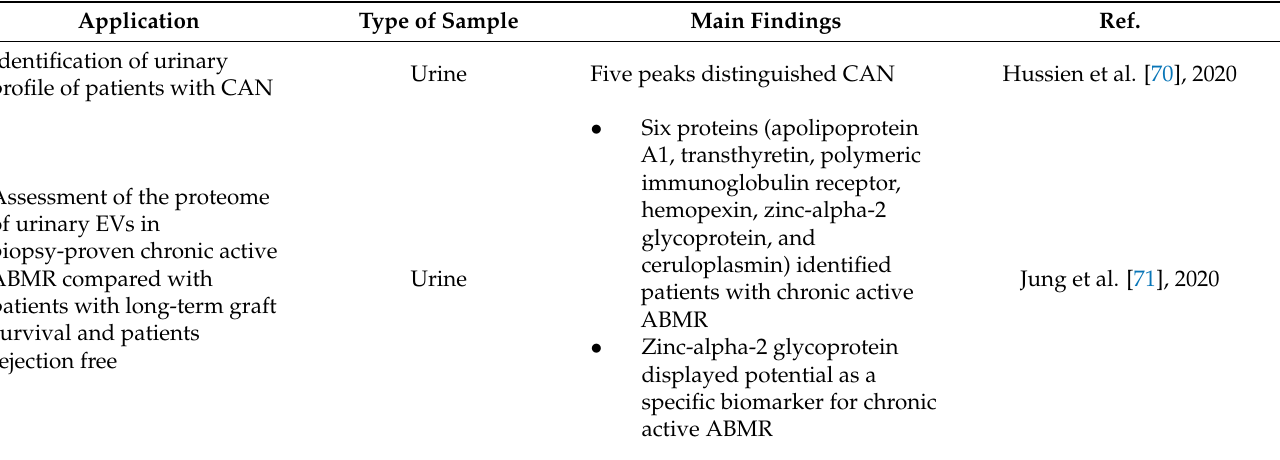
Table 5. Recent proteomic studies on chronic allograft dysfunction in the setting of kidney transplantation. Application Type of Sample Main Findings